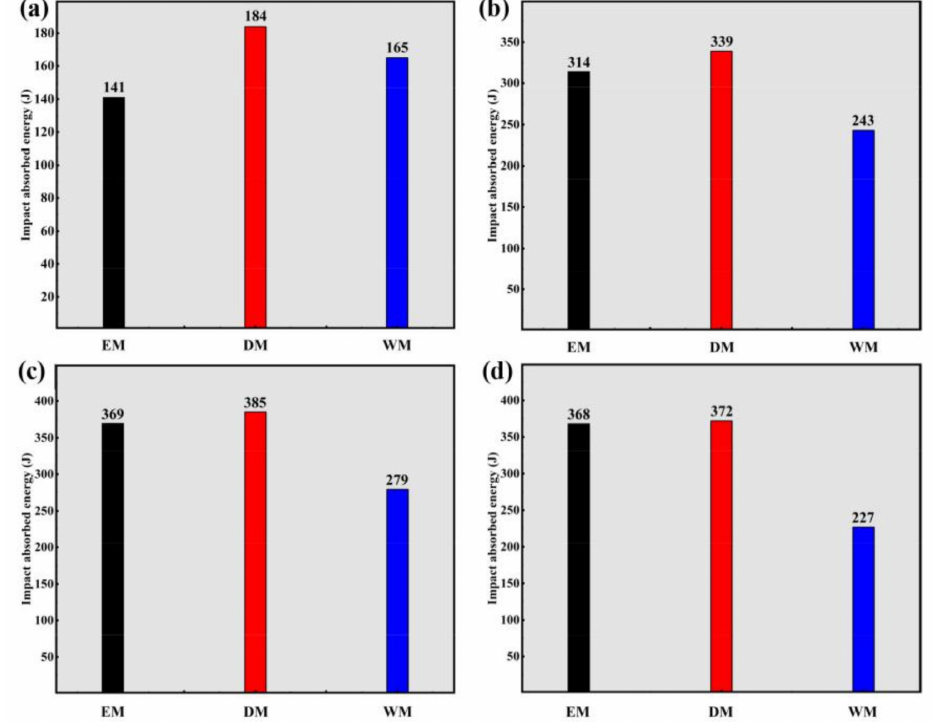
Figure 6. Impact-absorbed energy of Ti-6321 samples at different strain rates: ( a ) 1000 s − 1 ; ( b ) 2000 s − 1 ; ( c ) 3000 s − 1 ; ( d ) 4000 s − 1